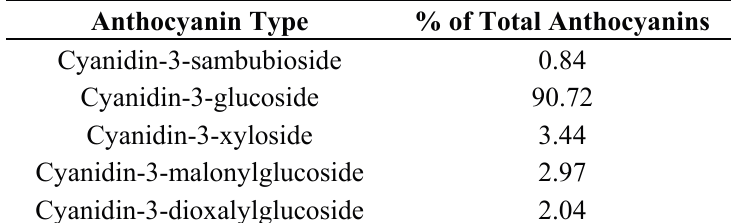
Table 16. Anthocyanin contents of acidified ethanol extract of blackberry